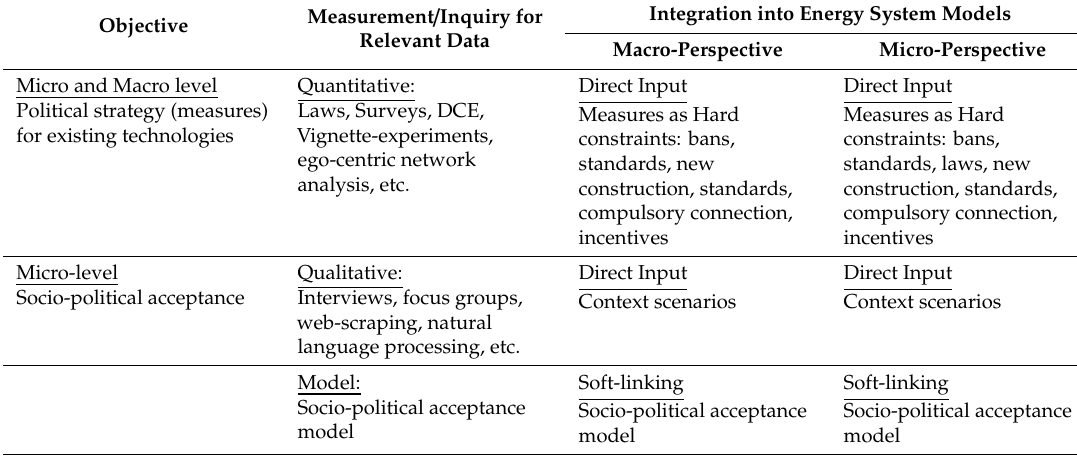
Table 5. Overview of objectives, methods of empirical data inquiry and possibilities to integrate socio-political acceptance into energy system models